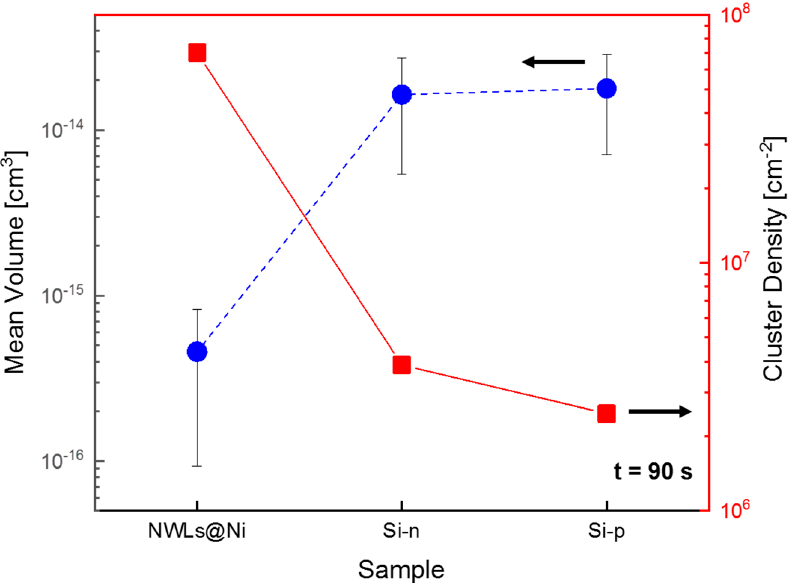
Figure 5. Mean volume and cluster densities for the NiO NWL_90, Si- n _90 and Si- p _90 samples. The different size distribution strongly affects the mean volume values: the NiO NWLs sample presents Au clusters with a mean volume 40 times smaller than those on the Si substrates. Moreover, the same NiO NWL sample presents a cluster density 20–30 times greater than the Si substrates.